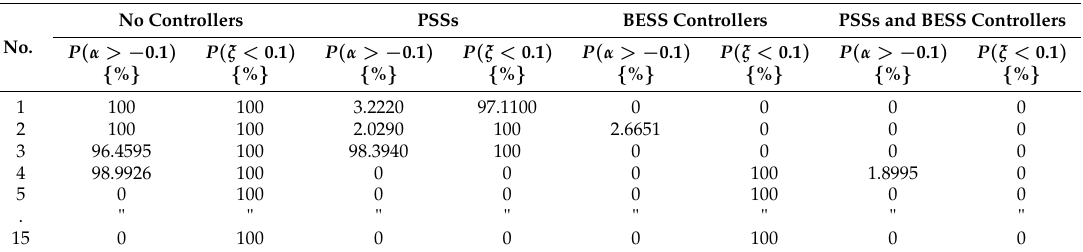
Table 9. Stability indices under different controller conditions for Scenario 1 using OBTM.